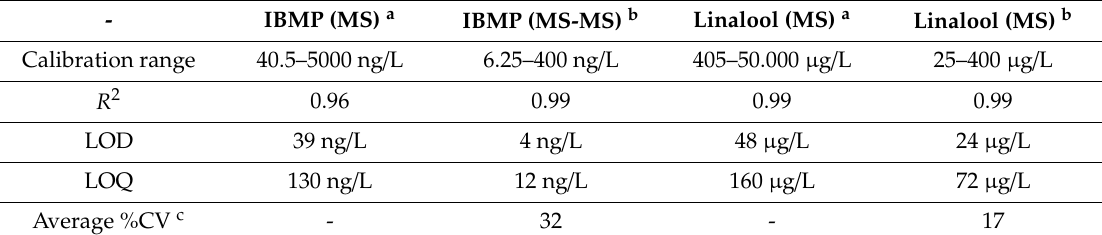
Table 1. Figures of merit for IBMP and linalool in grape homogenate and juice, respectively.